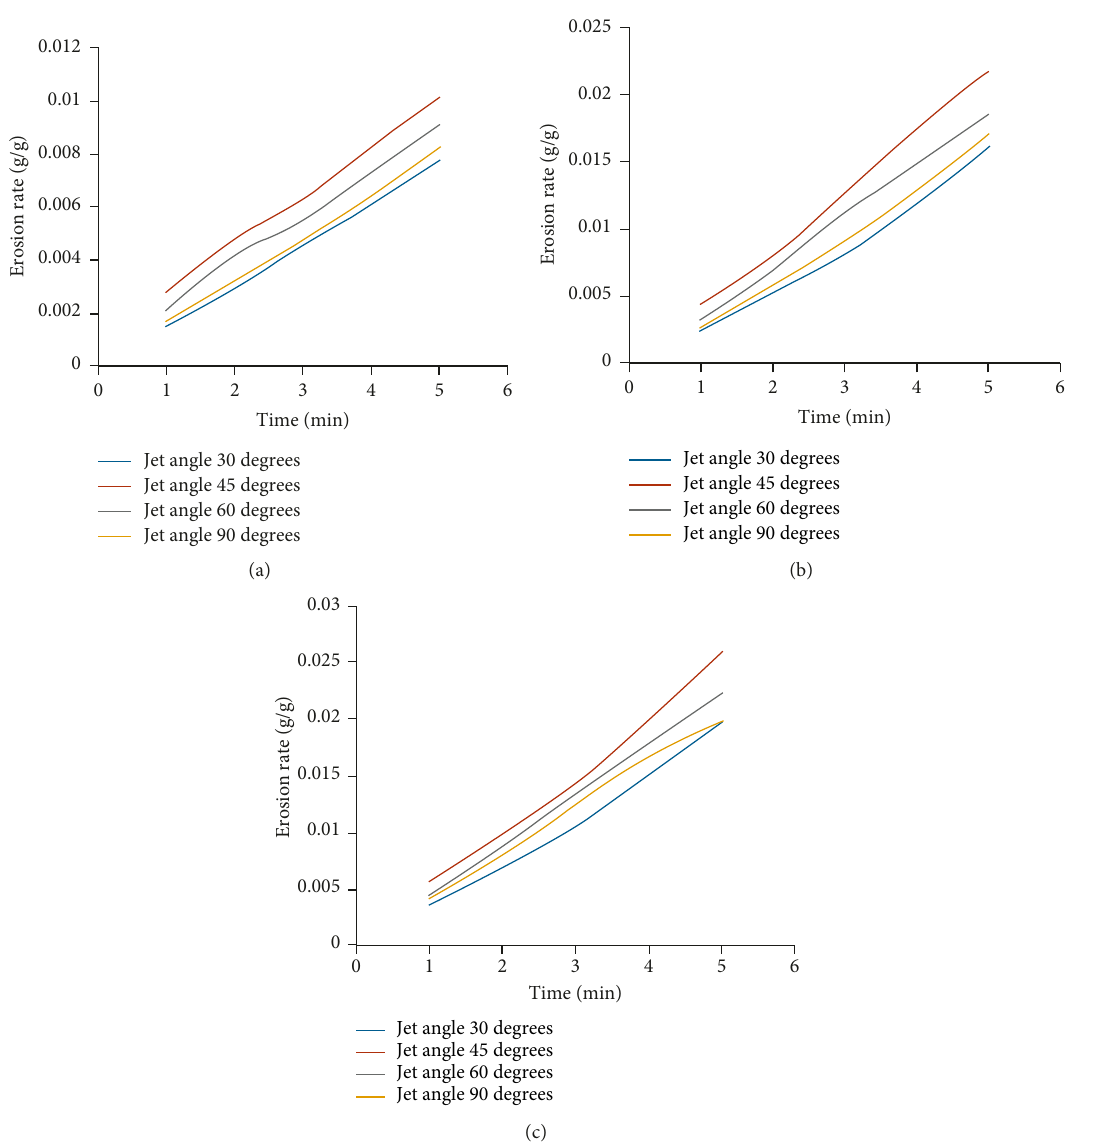
Figure 4: 5 layers glass fibre. (a) 1 bar pressure and 5% micro carbon powder filler. (b) 1.5 bar pressure and 5% micro carbon powder filler. (c) 2 bar pressure and 5% micro carbon powder filler.